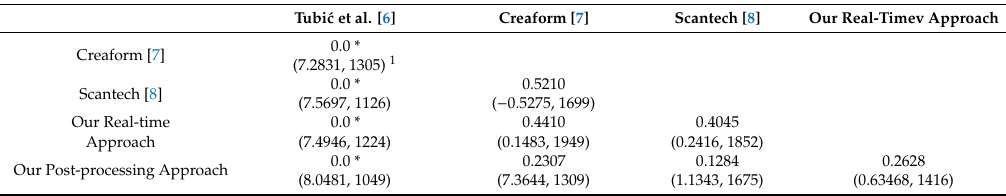
Table 7. Welch’s t -test for the plastic shell.